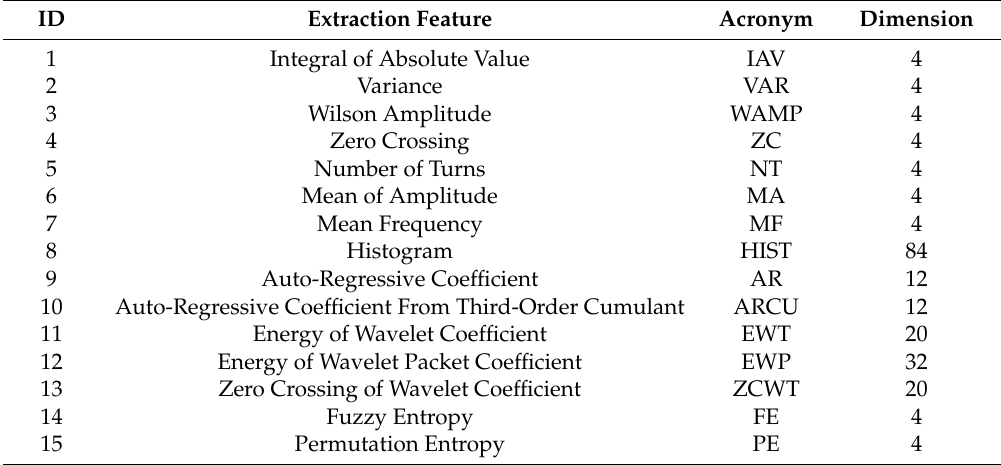
Table 1. List of